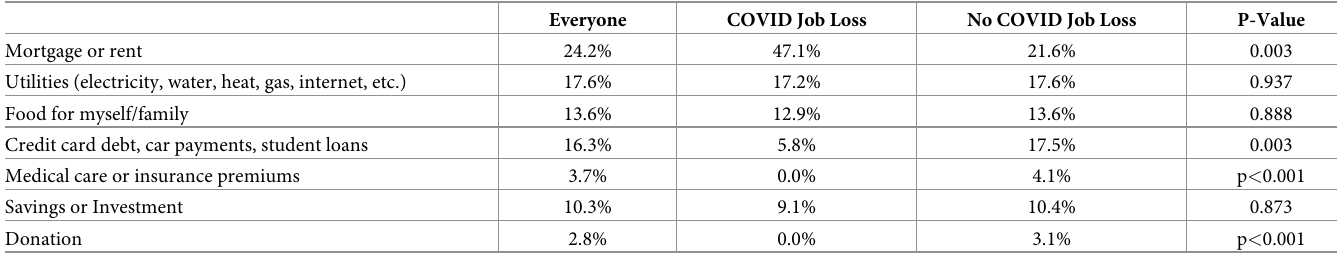
Table 5. Priority for stimulus check spending.